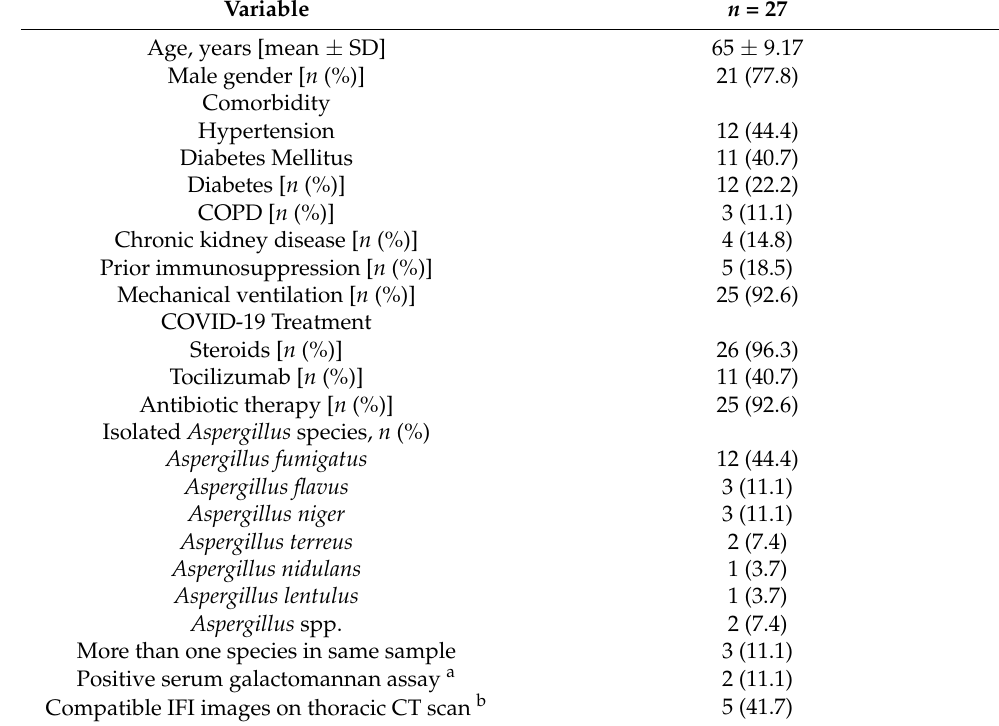
Table 1. Demographics and clinical characteristics of the study